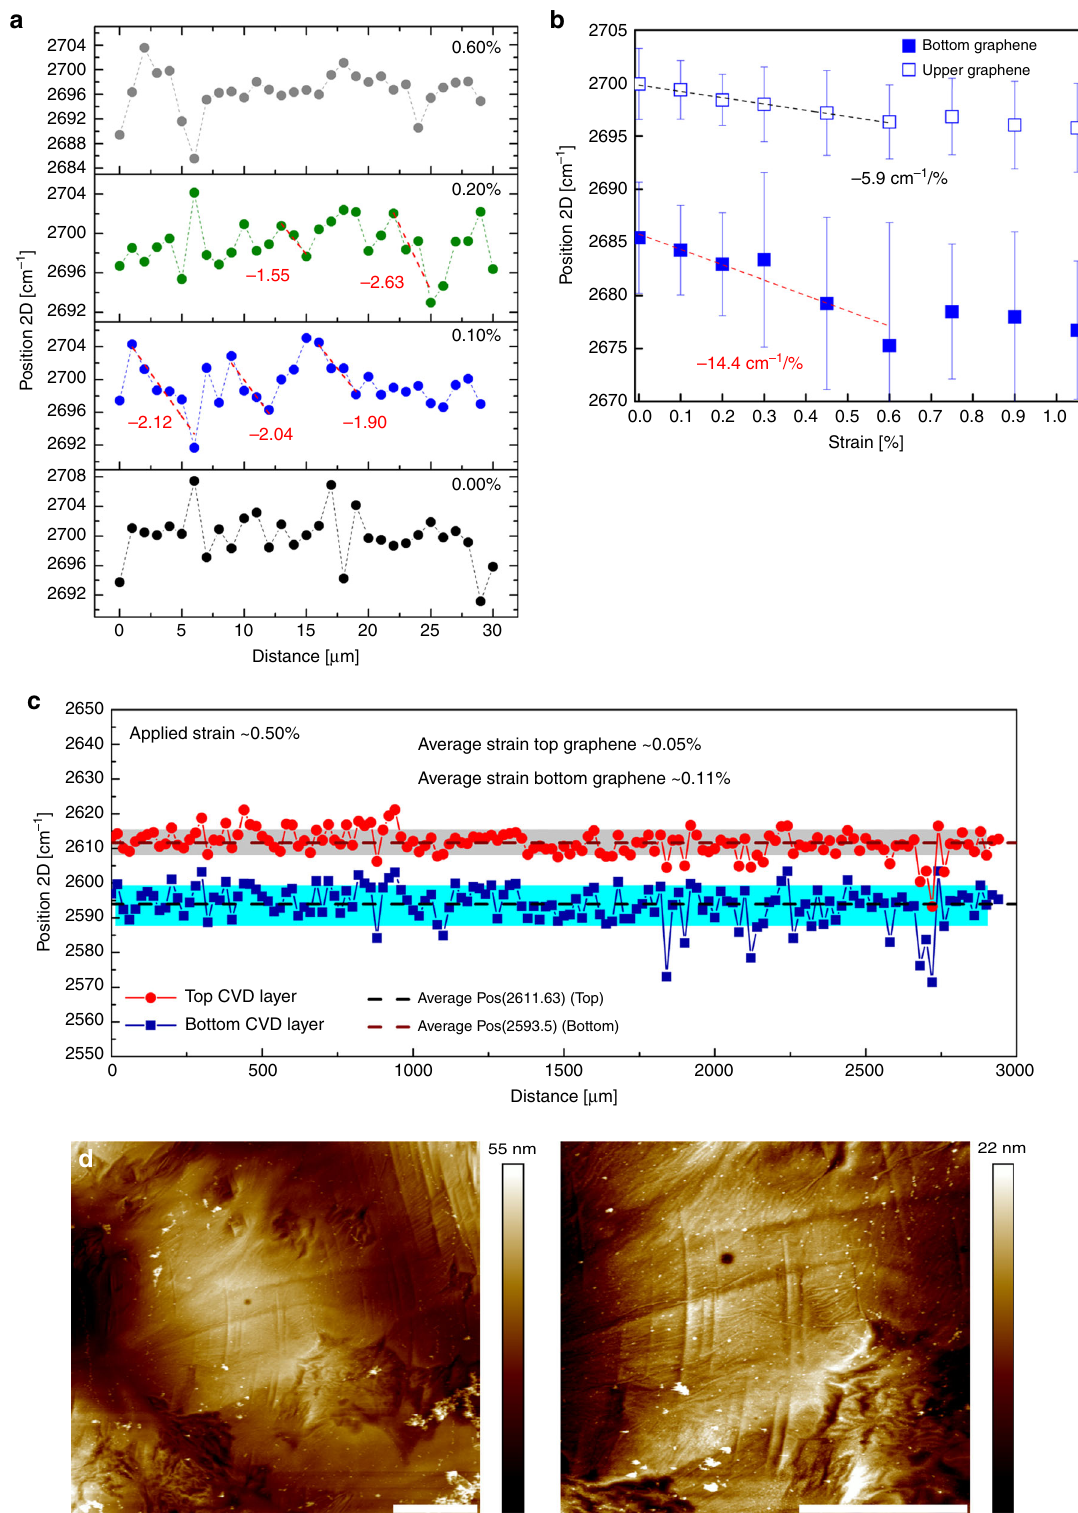
Fig. 5 Shearing of CVD graphene – graphene sample. a The position of the 2D peak versus distance for the top CVD single-layer graphene under various levels of tension. In-plot values correspond to slopes shown with dashed lines. Similar values of the slopes indicate similar ILSS. b The average shift of the 2D peak per increment of strain for the bottom and top CVD single layers for a distance of 30 microns. c Raman mapping over a 3-mm distance of a CVD/ CVD bilayer specimen with a scan step of 10 μ m. The average position is presented by the dashed lines and the standard deviation with the shaded colours. The corresponding average values of strain are also mentioned in the graph. Note: The experiment in ( c ) performed with a laserline excitation of 785 nm resulting in different frequencies compared to ( b ), for which a laserline of 514 nm was used. In SI, the response for the whole strain regime is presented. d AFM image (left) of the as-deposited CVD on the polymer bar, and (right) its x2 magni fi cation. The scale bar is 2